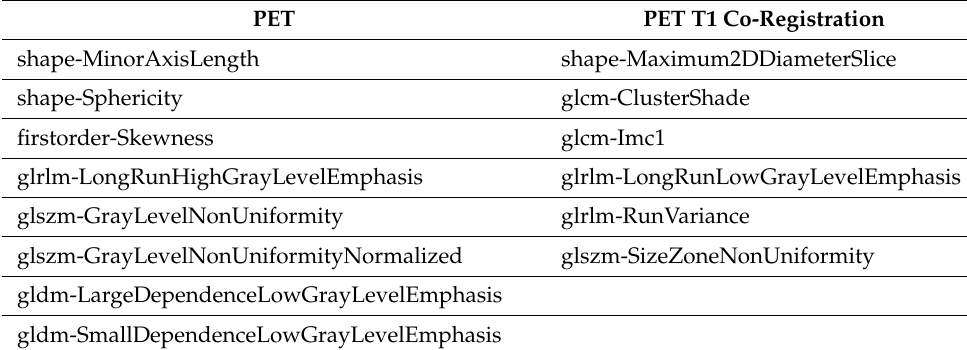
Table 3. The different features selected in PET and PET co-registered with T1